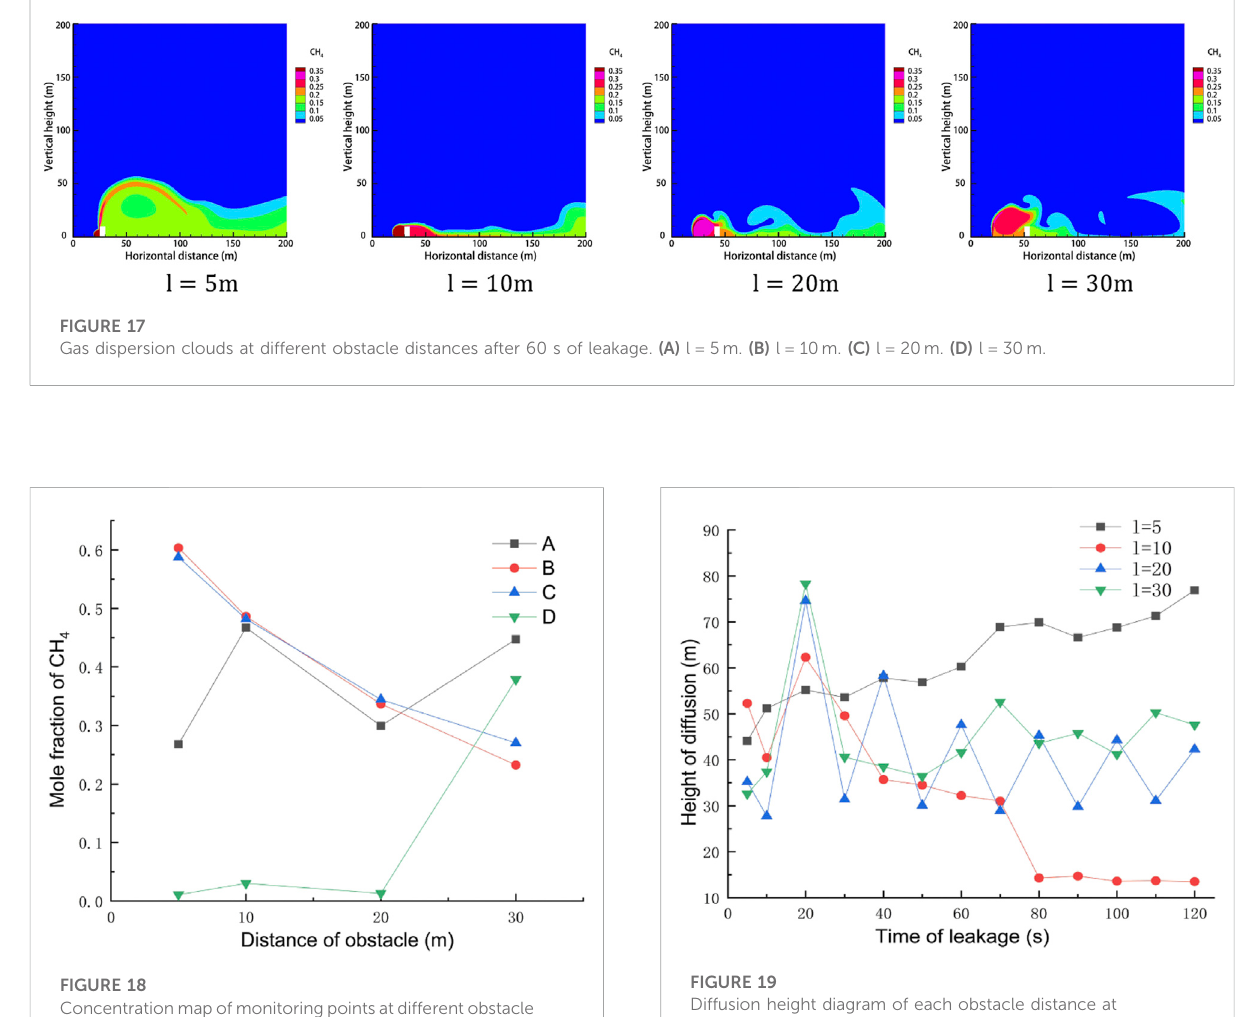
FIGURE 19 Diffusion height diagram of each obstacle distance at different